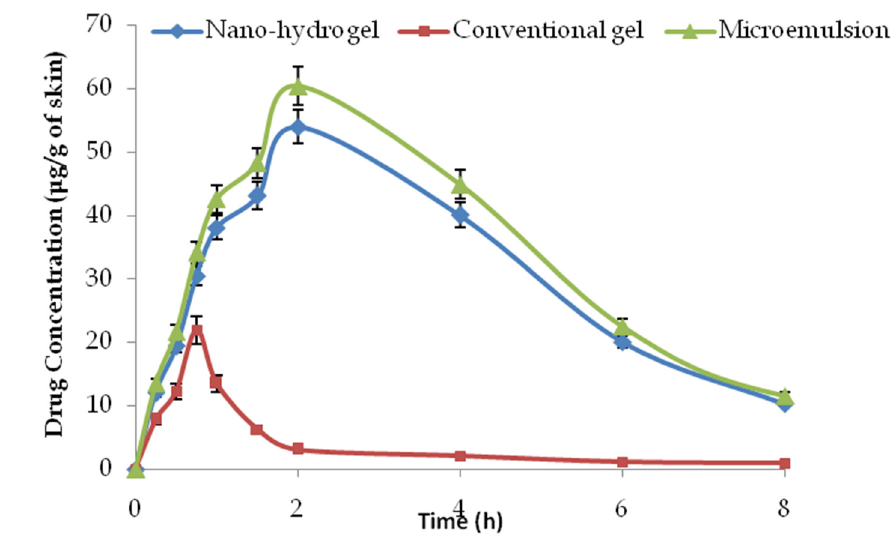
Figure 11. Mean plasma mangiferin concentration versus time graph in rodents (n = 4). Table 2. The dermal pharmacokinetic parameters obtained from the skin drug concentration–time profile of mangiferin in rodent skin.